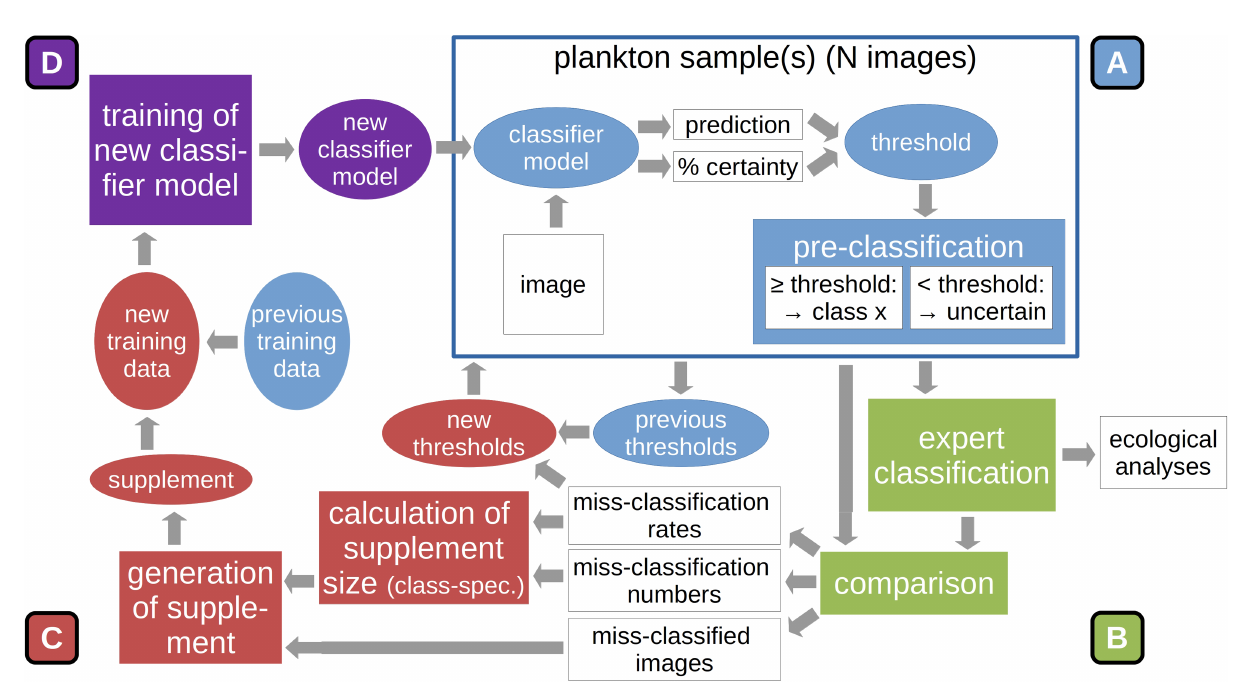
FIGURE 2 | Sequence of main procedures in the DOC pipeline: After the automatic classi fi cation (A) and expert validation of a set of plankton samples (B) , the original model training set is stocked up with a selection of miss-classi fi ed images, based on class-speci fi c miss-classi fi cation rate. This constrained update reduces the dominance of naturally-abundant classes in the add-on set. Also, classi fi cation thresholds used in automatic pre-classi fi cation are reduced based on miss- classi fi cation rates (C) . A new classi fi er model is trained on this updated training set. The new model is used to classify the next set of plankton samples (D) . Further details are given in the